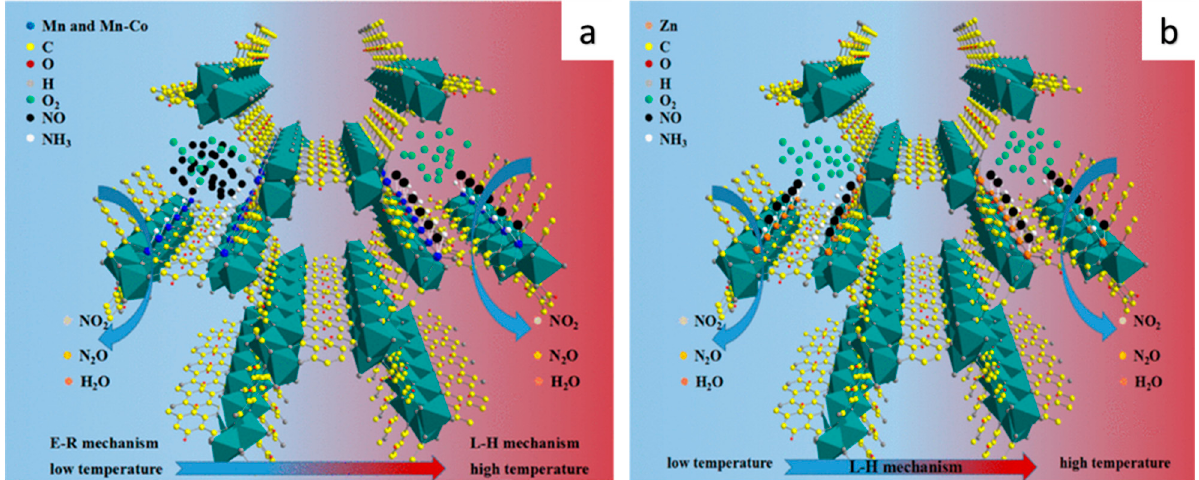
Figure 5. Schematic diagram of ( a ) MOF-74-MnCo, ( b ) MOF-74-Zn NO x SCR mechanism [38] (copyright 2016 American Chemical Society).